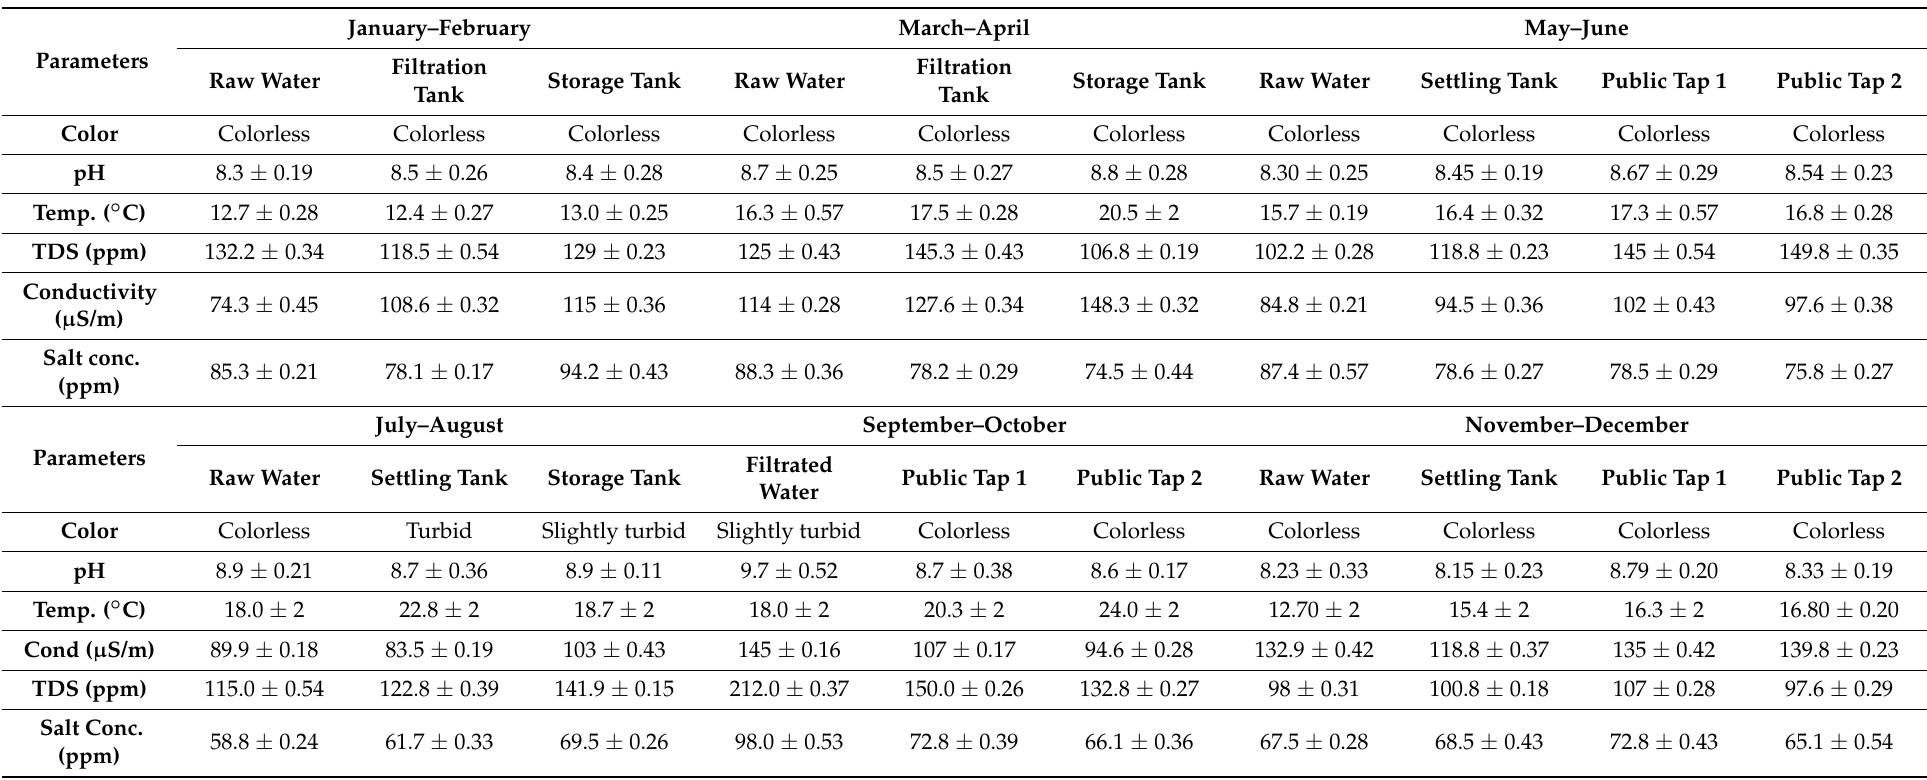
Table 3. Analysis of samples collected from source Dhalli